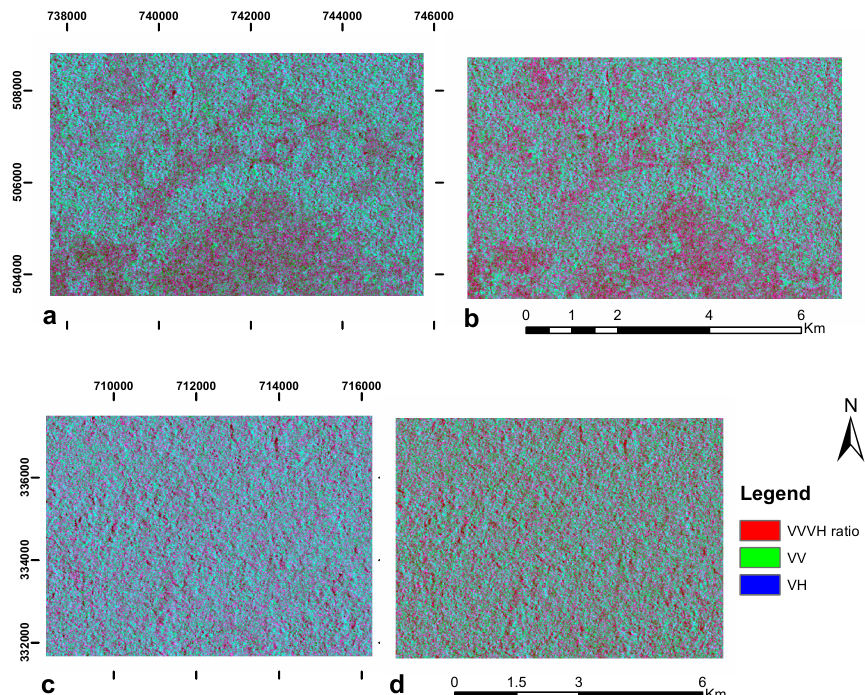
Figure 3. Illustration of SAR backscatter in the study sites: ( a , b ) wet and dry season SAR backscatter of the landscape in Bokito site, respective images acquired on 12 June 2016 and 10 November 2017. ( c , d ) wet and dry season SAR backscatter of the landscape in Efoulan site, respective images acquired on 16 August 2016 and 27 November 2017. Map CRS: WGS 84/UTM.